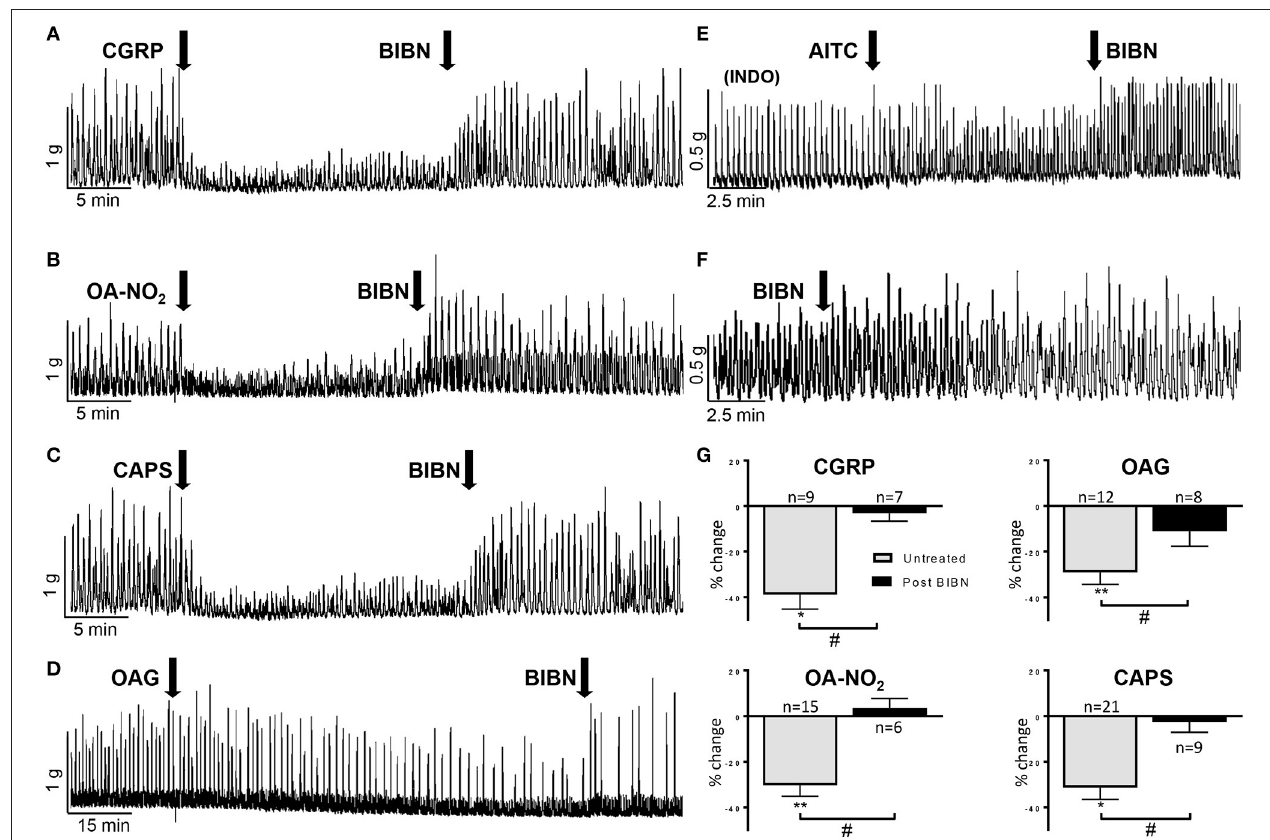
FIGURE 4 | (A–D) BIBN (25 µ M) a CGRP antagonist reverses the inhibition of SBCs elicited by CGRP (100nM), OA-NO 2 (30 µ M), CAPS (1 µ M), and OAG (50 µ M). (E) Pretreatment with indomethacin (INDO, 500nM) average of 25min before application of AITC blocks the excitatory effect of AITC (100 µ M) on SBCs and unmasks an inhibitory effect that is reversed by BIBN (25 µ M; see Figure 5H for graph). (F) BIBN (25 µ M) alone elicits a gradual increase in the amplitude of SBCs. (G) Graphs summarizing the magnitude of the inhibition of SBCs (% change of AUC) elicited by CGRP, OAG, OA-NO 2 , and CAPS and the block of the inhibition by pretreatment of BIBN. Statistics were performed on raw numbers: 2-tailed t -test, * P < 0.05 and ** P < 0.001 and a two-way ANOVA with Bonferroni multiple comparisons post-hoc test (brackets), # P < 0.05; n , number of